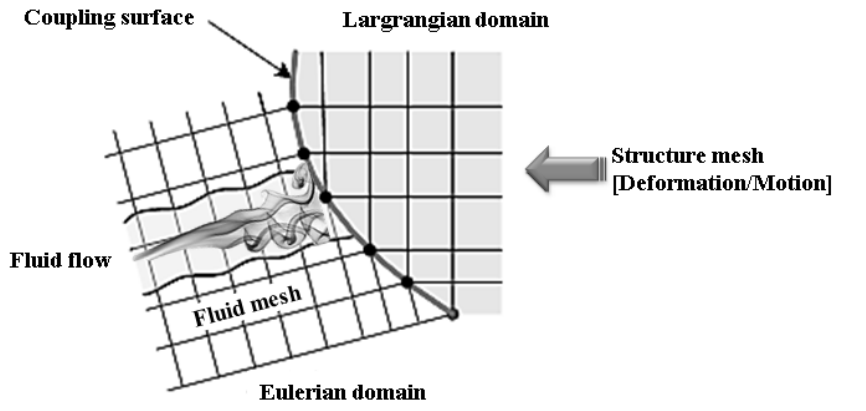
Figure 1. Lagrangian – Eulerian interaction scheme.